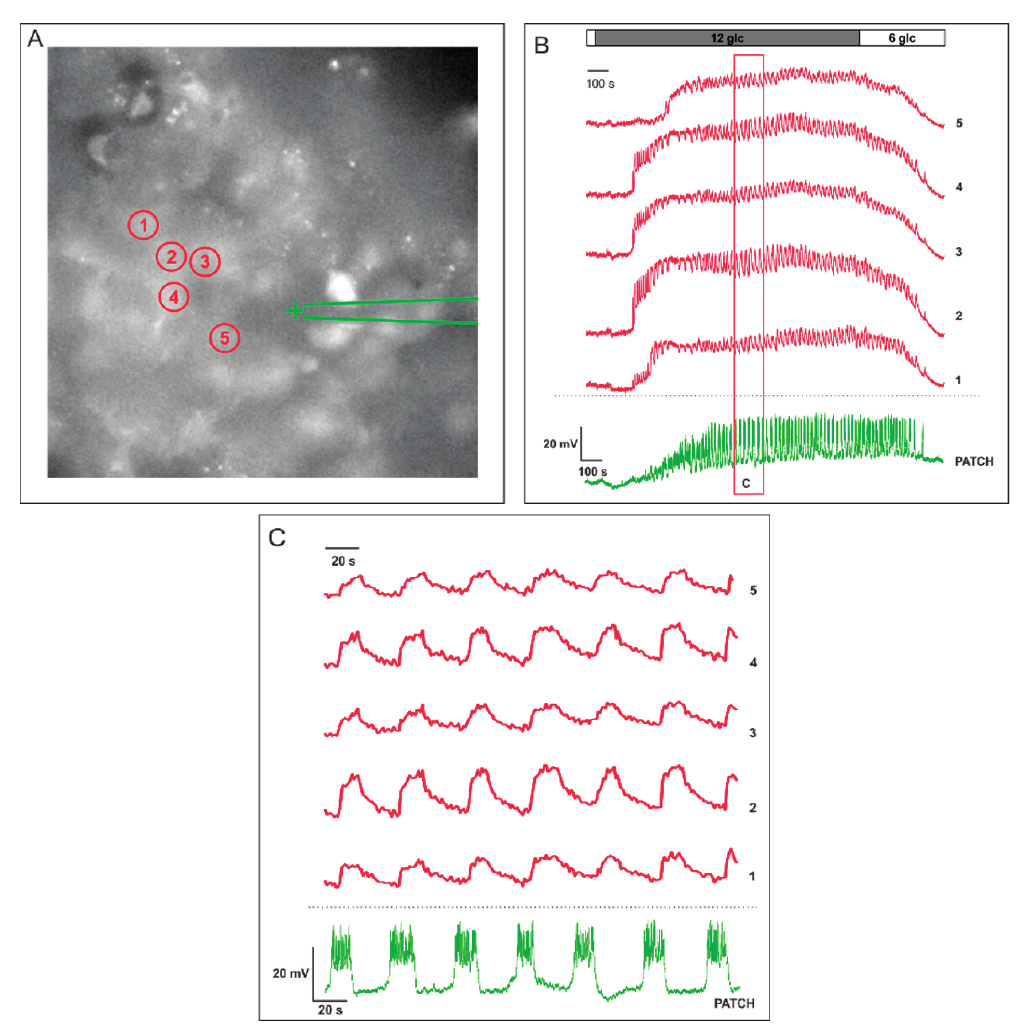
Figure 2. Simultaneous measurement of changes in MP using whole-cell patch-clamp and [Ca 2+ ] i using Oregon Green BAPTA-1 AM. ( A ) The [Ca 2+ ] i sensitive dye OGB-1 labels intracellular compartments of cells. The numbers indicate cells shown in panels B and C. The patched cell is indicated with +; ( B ) the green trace represents oscillations in MP after increasing the concentration of glucose from 6 to 12 mM. The upper five red traces (1–5) represent [Ca 2+ ] i dynamics obtained from the five cells indicated in A. The red rectangle encloses the area shown in panel C under magnification; and ( C ) a more detailed depiction of the response from panel B. Note that each burst in MP (green) is followed by a [Ca 2+ ] i (red) oscillation in other